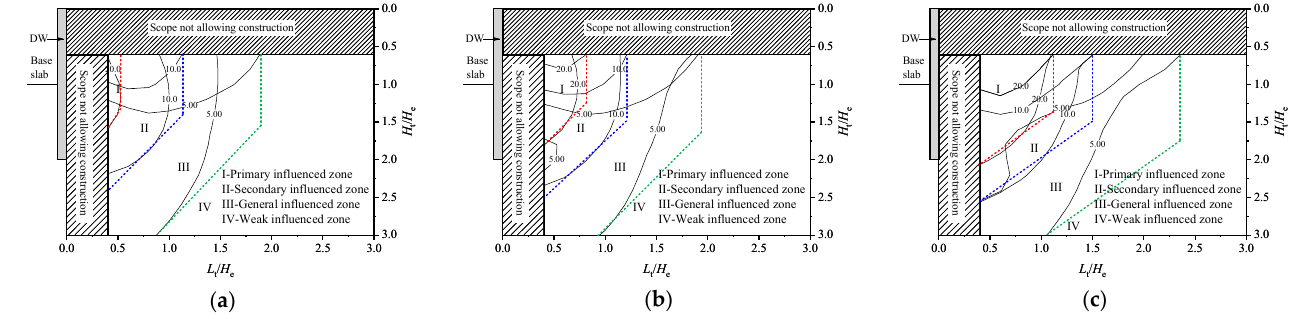
Figure 6. Influenced zone of deep excavation on adjacent tunnel displacement ( H e = 15 m): ( a ) δ hm = 0.18% H e ; ( b ) δ hm = 0.3% H e ; ( c ) δ hm = 0.7% H e . To quantitatively characterize the scope of the influenced zone, the shape of the influenced zone is simplified as a right trapezoid according to its features, the isoline of three-level tunnel displacement control standards is simplified as a polyline, and the coordinates of three points on the polylines are defined: M (width coefficient), N 1 and N 2 (depth coefficients), as shown in Figure 9. These three parameters reflect the influence potential of deep excavation on the tunnel displacement in horizontal and vertical directions, and the larger values of the above parameters, the greater the influence degree